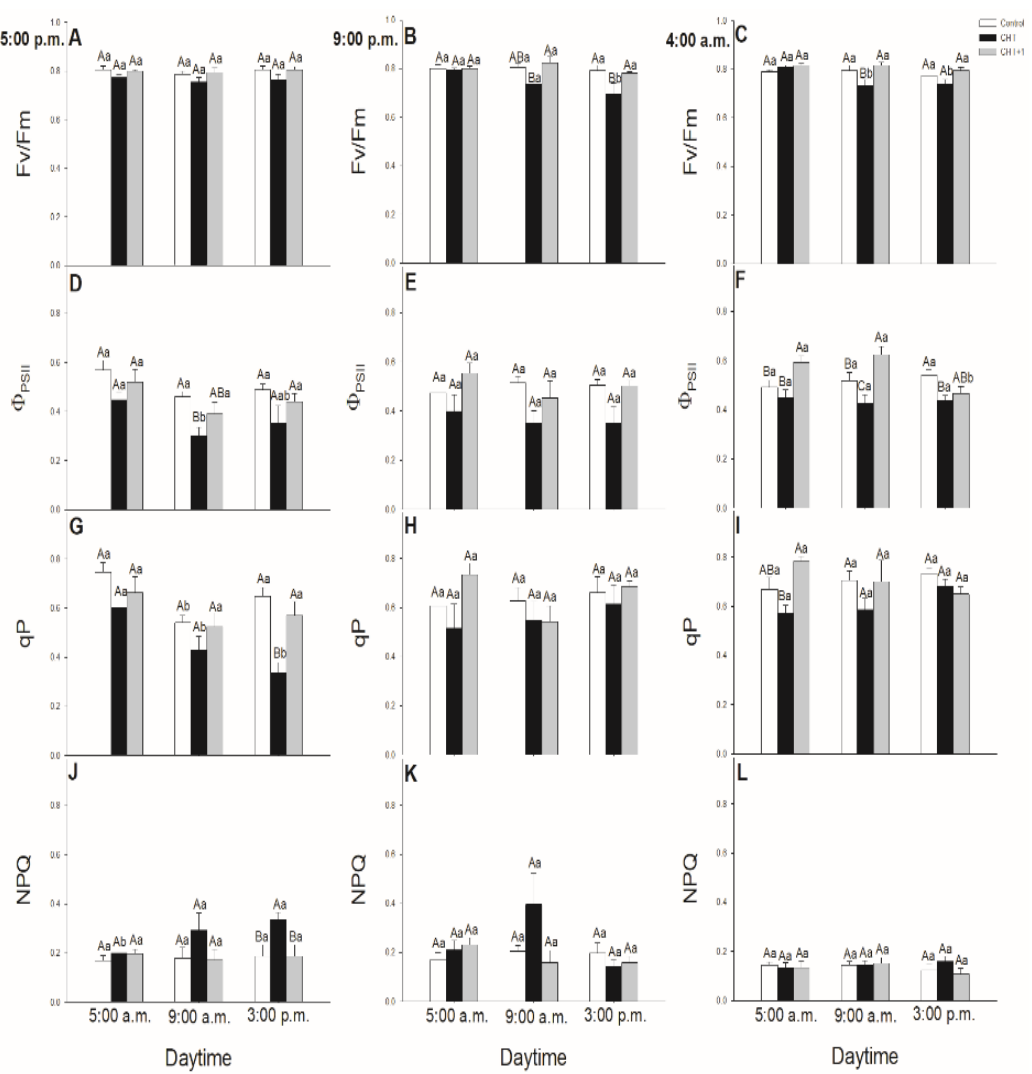
Figure 5. Changes in the chlorophyll a fluorescence parameters [Fv / Fm ( A–C ), Φ PSII ( D–F ), qP ( G–I ), NPQ ( J–L )] of stomata on the abaxial epidermal strips of intact tomato plants treated foliar with 100 µ g mL –1 chitosan (CHT) dissolved in the experimental bu ff er (1 mM AA, 10 mM MES / TRIS, 10 mM KCl, 0.1 mM CaCl 2 , pH 6.15) at di ff erent daytimes: at the end of light cycle (17:00 hrs), at night (21:00 hrs), at dawn (04:00 hrs). Measurements were disposed at constant times after treatments (05:00, 09:00 and 15:00 hrs). Means ± SE, n = 3. Means were analyzed by two-way ANOVA, significant di ff erences among the data were analyzed by Holm–Sidak test. Mean values significantly di ff erent at P < 0.05 were signed with di ff erent letters, upper case letters indicate the e ff ects of the treatment at the same daytime, and lower case letters indicate the e ff ects of the daytime under the same treatment. (Control: treatment with 1 mM Acetic acid bu ff er (AA); CHT: treatment with 100 µ g mL –1 chitosan in experimental bu ff er containing AA; CHT + 1: untreated distal leaf level from the CHT-treated one). Interestingly, when leaves were treated with CHT in the morning at 08:00 hrs, when stomata were already opened, Fv/Fm, Φ PSII and qP did not change significantly in the guard cells (Figure 6 A –